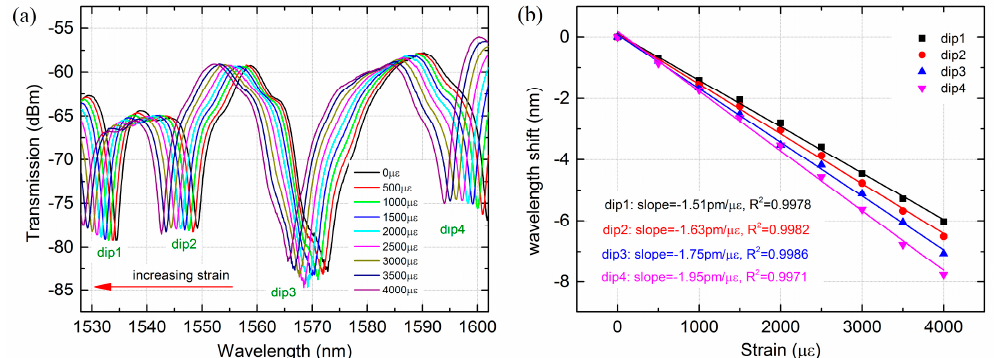
Figure 5. ( a ) Transmission spectra change of the MZI with 45 mm PCF as the strain increases; ( b ) wavelength shifts of three dips as a function of strain.